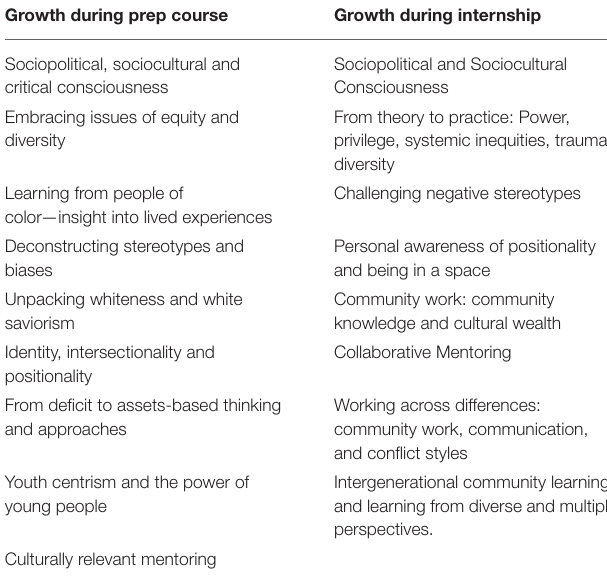
TABLE 2 | Summary of thematic